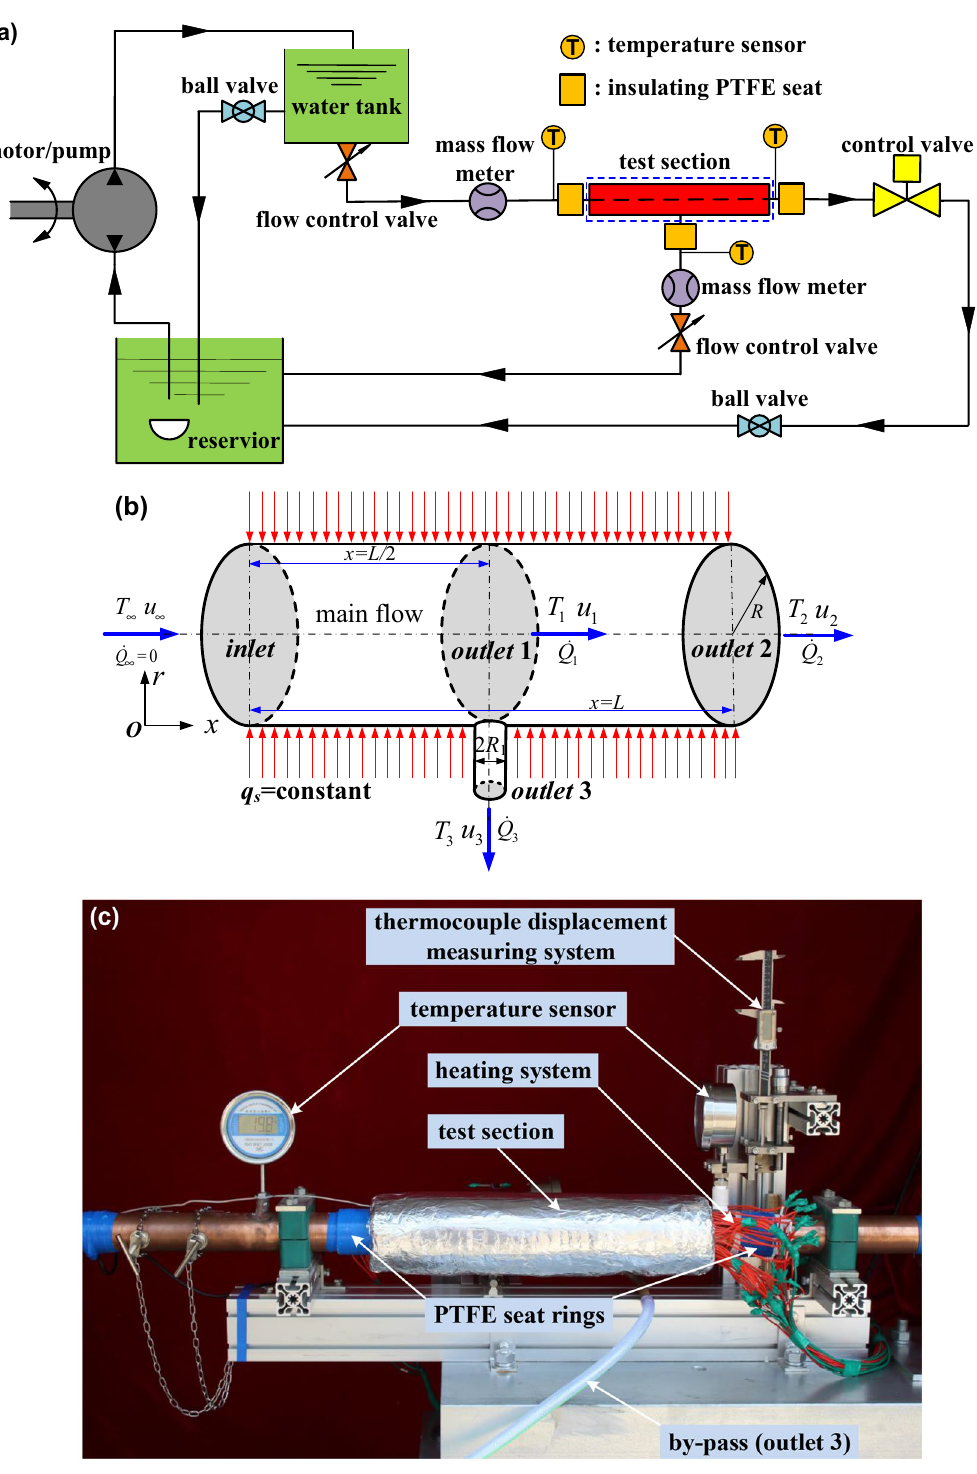
Figure 2. Experimental setup. ( a ) The layout of the laminar flow test rig. ( b ) Test section of the laminar flow geometry. ( c ) Front view of experimental setup and ( d ) Rear view of experimental setup. ( e ) Installation and connection of the by-pass copper tube at outlet